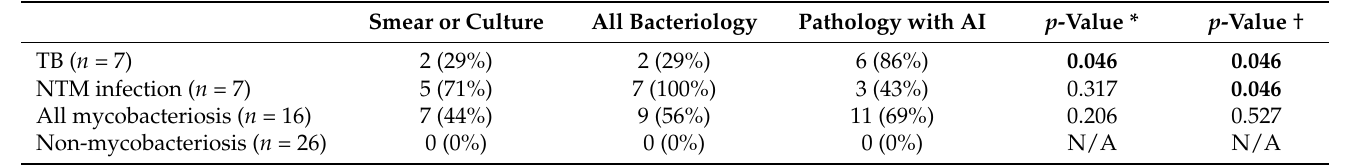
Table 3. Comparison of bacteriological tests and AI-supported